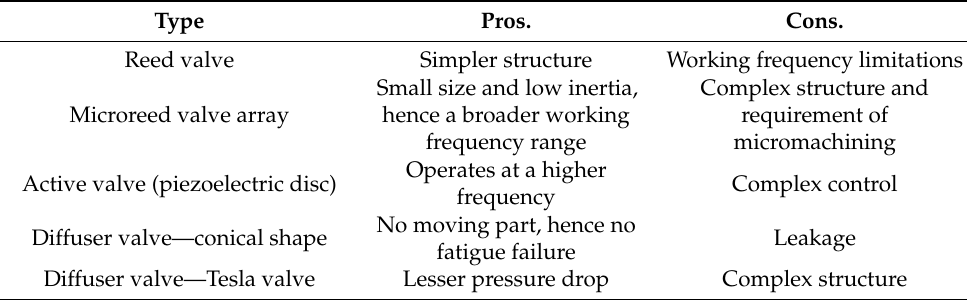
Table 7. Comparison of valve types in the piezoelectric–hydraulic pump. Type